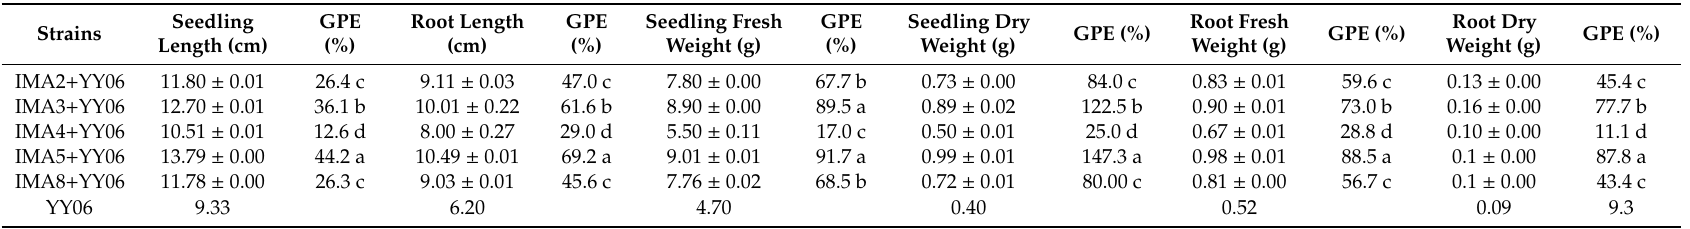
Table 4. E ff ect of five antagonistic bacterial strains on plant growth and biomass in in controlling eggplant bacterial wilt 40 days after inoculation.